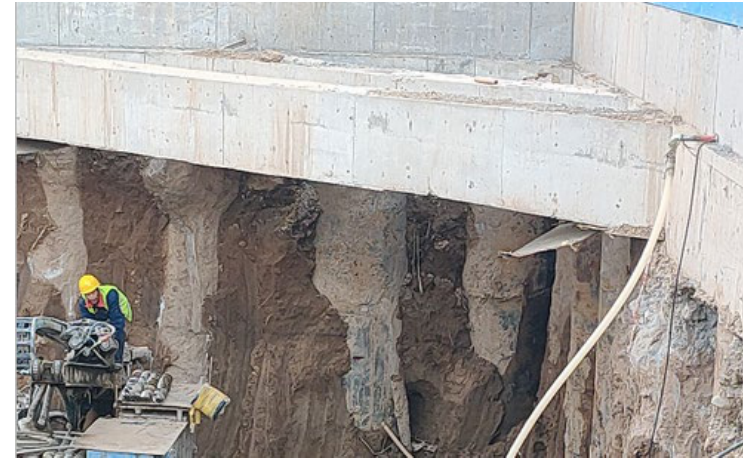
Figure 4. On-site construction of corner braces.